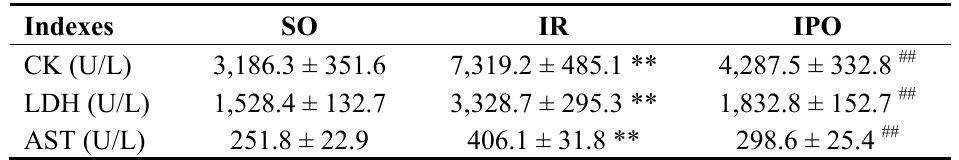
Table 4. Effect of ischemic postconditioning on serum CK, LDH and AST activities in IR rats.